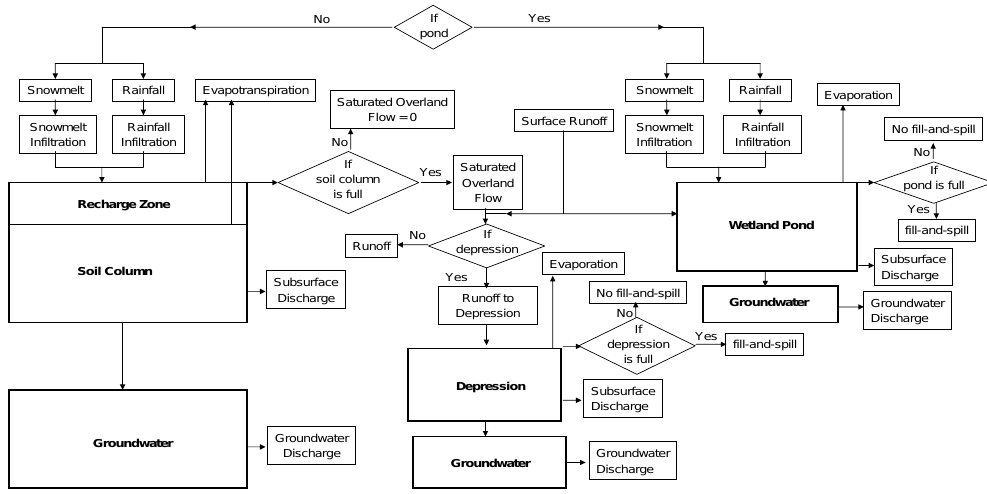
Fig. 3. Flowchart of a wetland module of soil moisture balance calculation with wetland or depression storage and fill-and-spill.